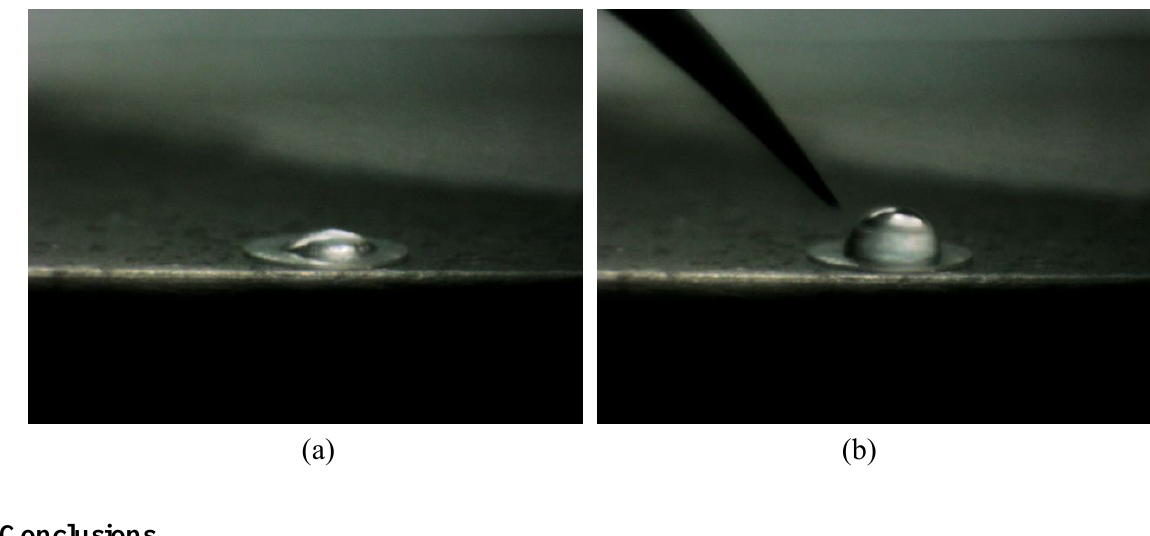
Figure 9. Behavior of the water droplets on the PNIPAAM grafted sapphire discs